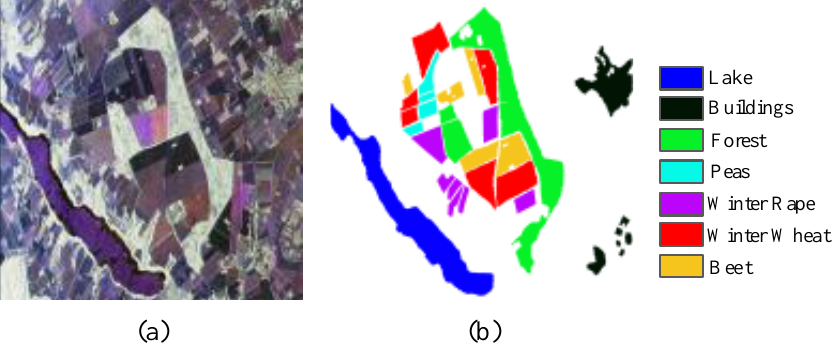
Figure 10. EMISAR Foulum dataset. ( a ) Pauli RGB map. ( b ) Ground truth